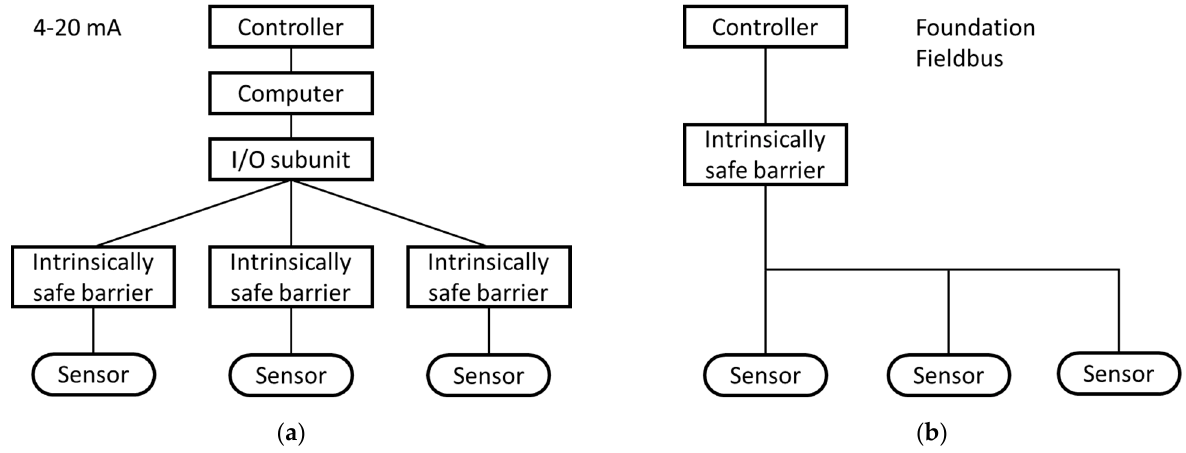
Figure 1. Example of limit alarm trip implementation considering the time behavior of a generic sensor’s output.